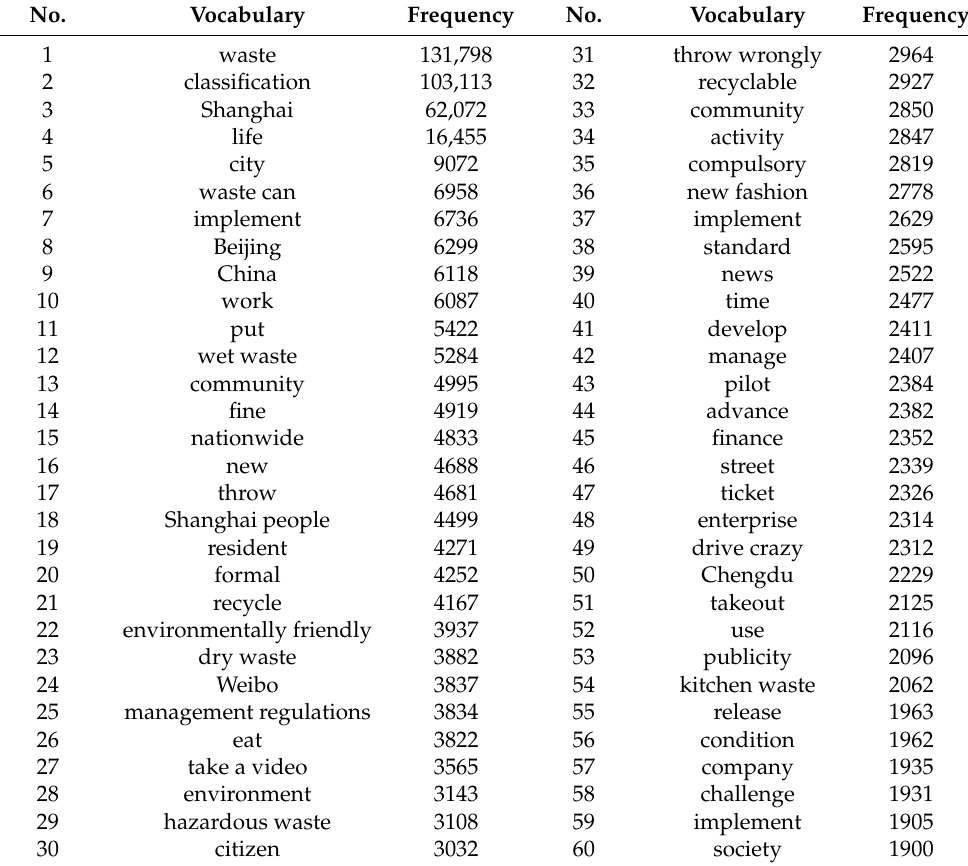
Table 1. High frequency vocabularies of all